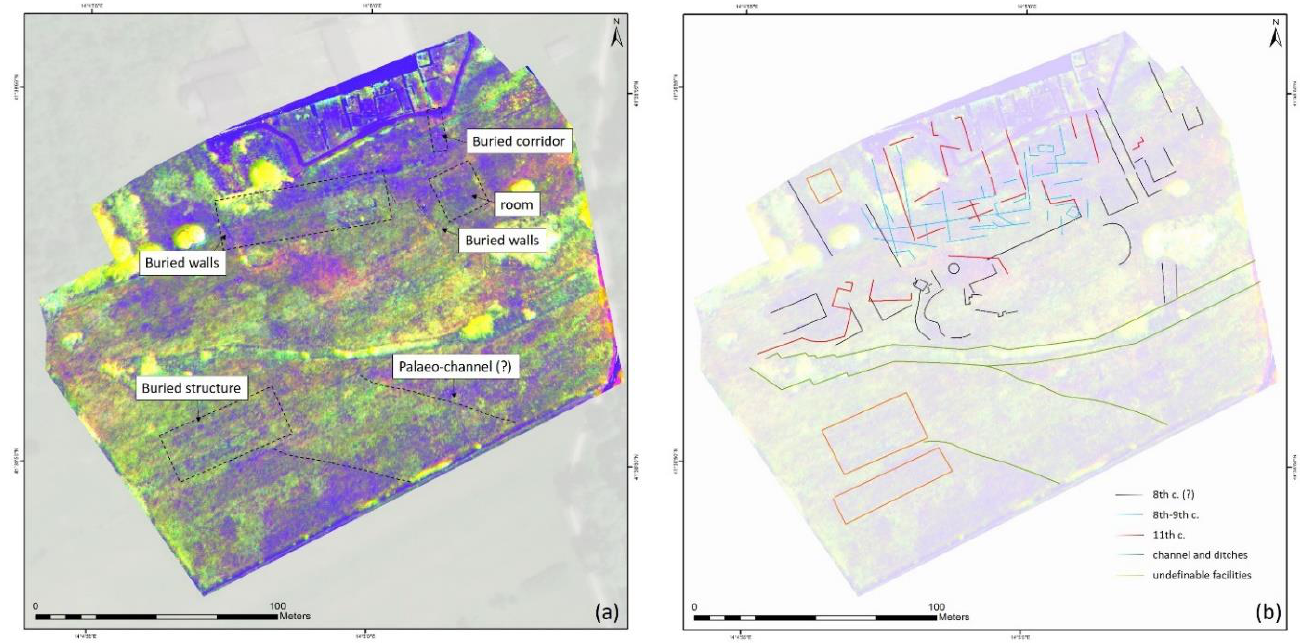
Figure 14. SPCA with annotation of features of no archaeological interest. Examples of vehicle traces, agricultural traces and traces left by the removal of trees are outlined and indicated by arrows.